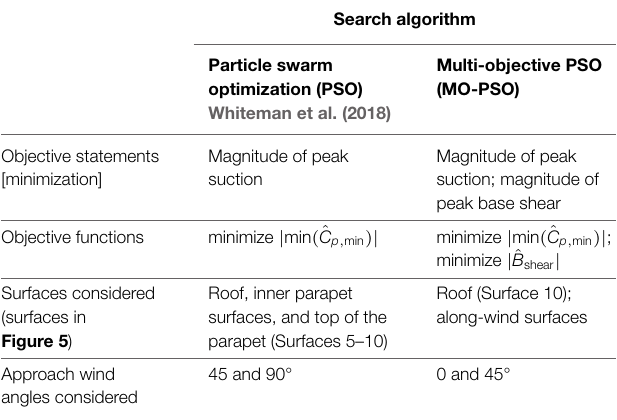
TABLE 2 | Comparison of details of stochastic optimization